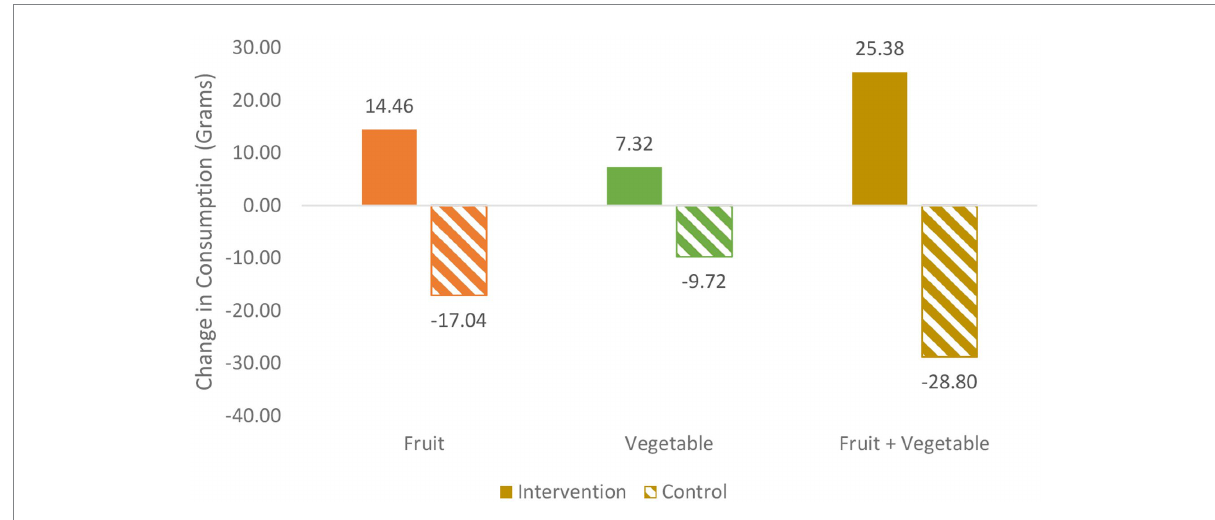
FIGURE 6 Pre-post change for intervention v. no intervention for F, V, and FV consumption in grams during snack sessions (of 300 g. F, 300 g. V